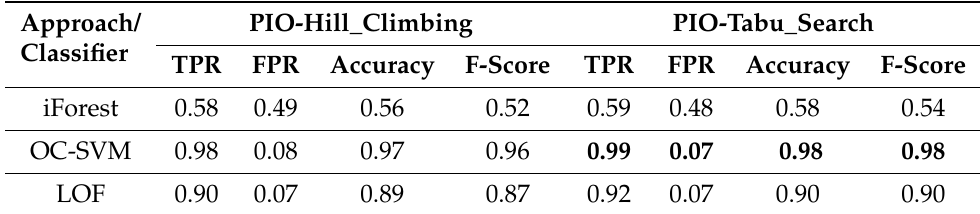
Table 9. The evaluation results for LS_PIO using labeled DNS exfiltration dataset [32].